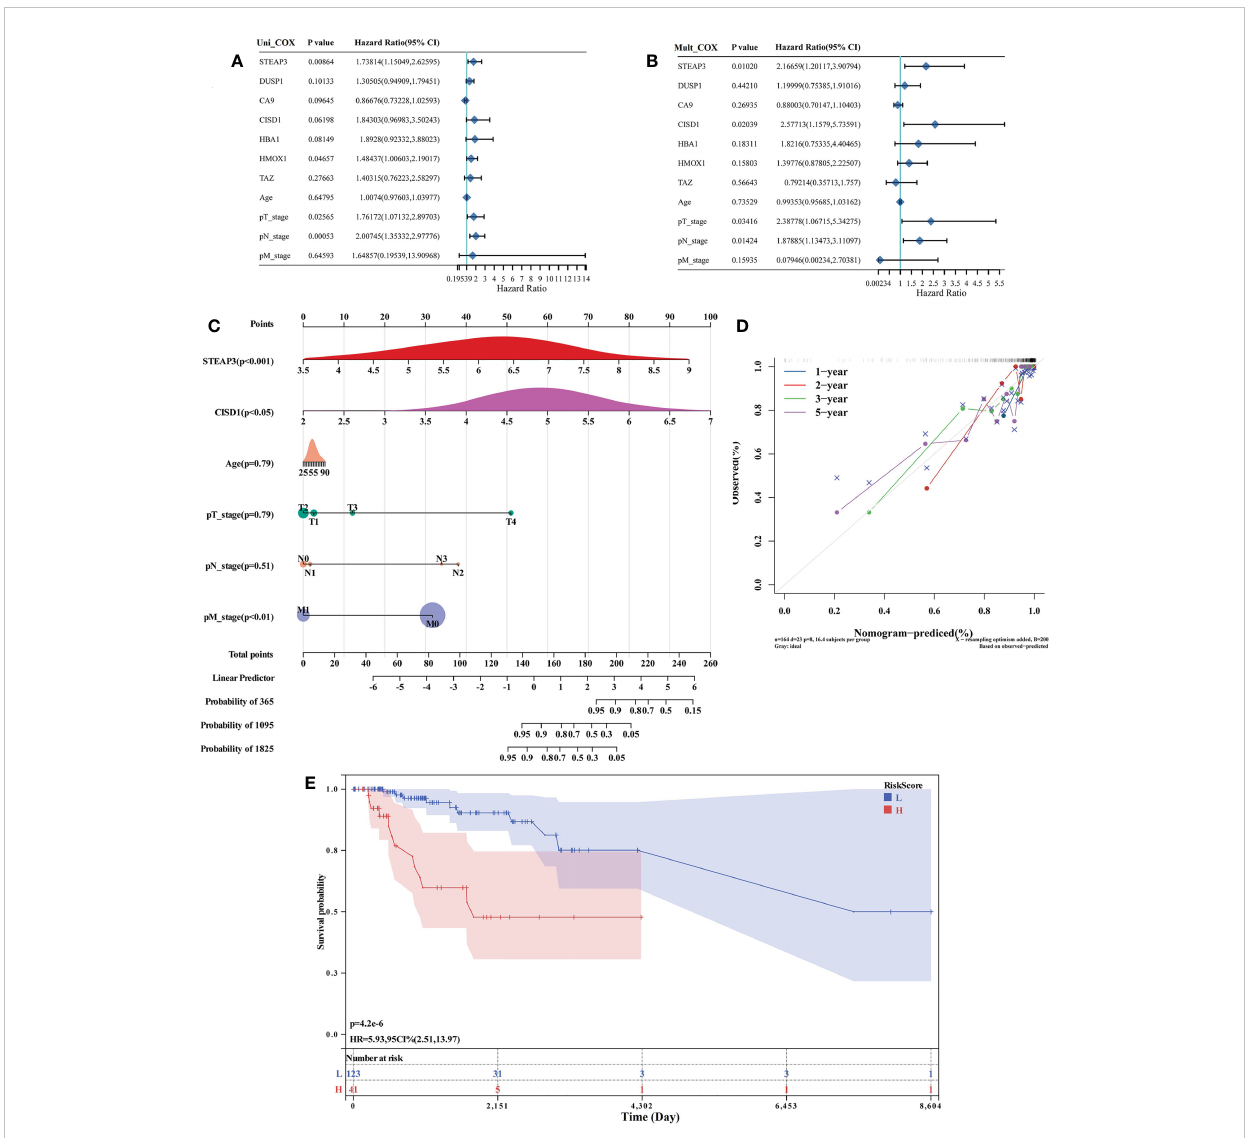
FIGURE 3 Identi fi cation and assessment of prognostic TNBC-associated FRGs. (A, B) Forest plot-based identi fi cation of TNBC patient risk factors identi fi ed through univariate (A) and multivariate (B) Cox regression analyses. (C) A nomogram was established based on multivariate Cox regression analysis results. (D) Calibration plot for the established Nomogram. (E) Evaluation of the developed Nomogram based on Kaplan-Meier OS